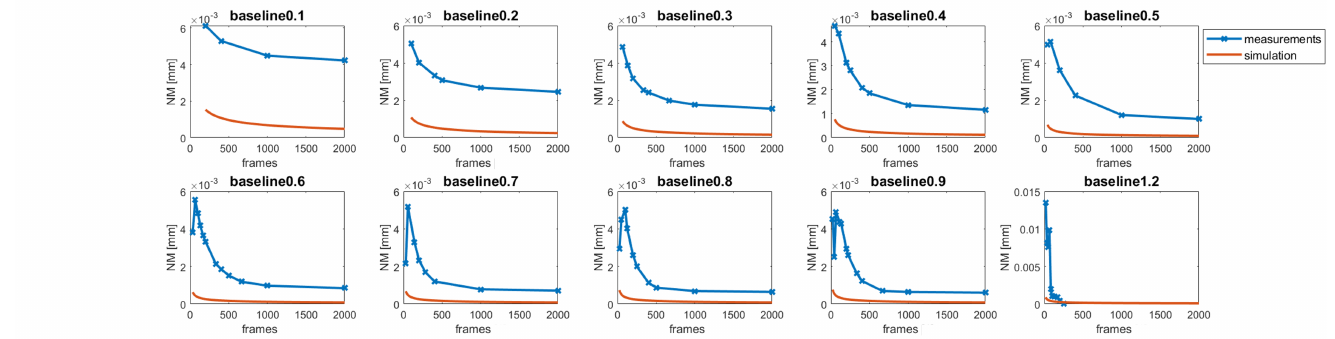
Figure 6. The results of temporal noise ( NM ) evaluation using the measuring and control surface plate. Different baselines with different oversampling numbers (frames) were chosen. The frames give the number of frames which were used for the 3D reconstruction.